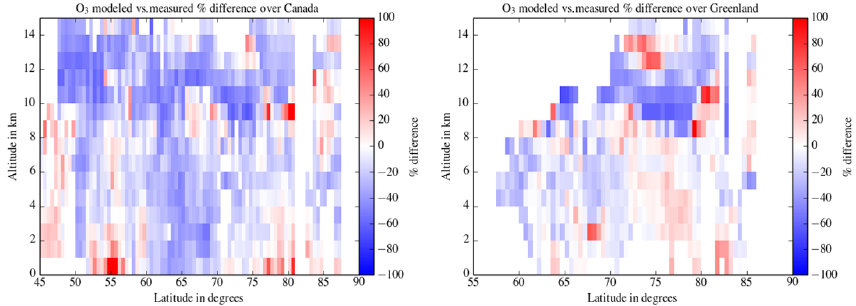
Figure 5. Same as Figs. 3 and 4 for the ozone mixing ratio relative differences between the WRF-Chem model and the